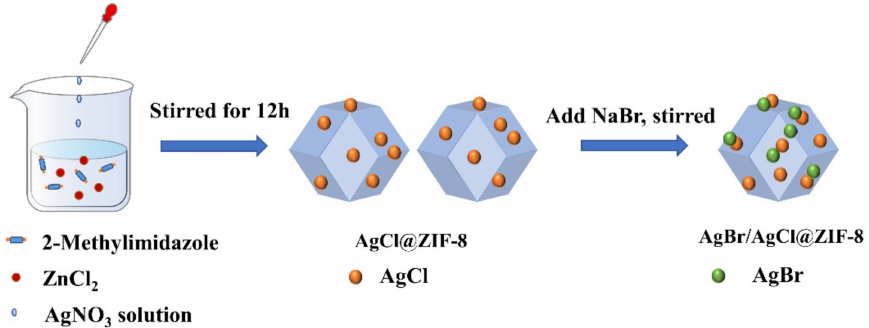
Figure 1. Flow chart of the preparation of